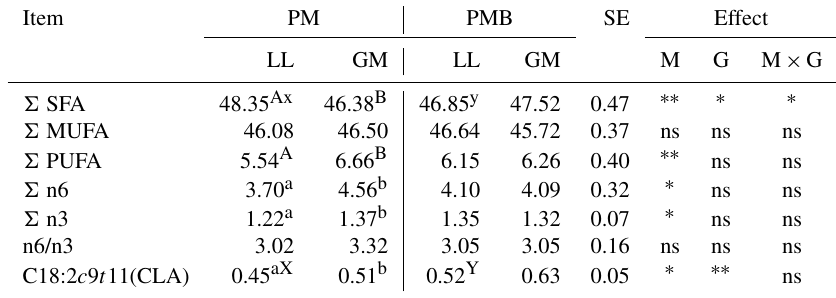
Table 4. The groups and chosen fatty acid for different genotypes and muscles (g100g − 1 of total fatty acid). Item PM PMB SE